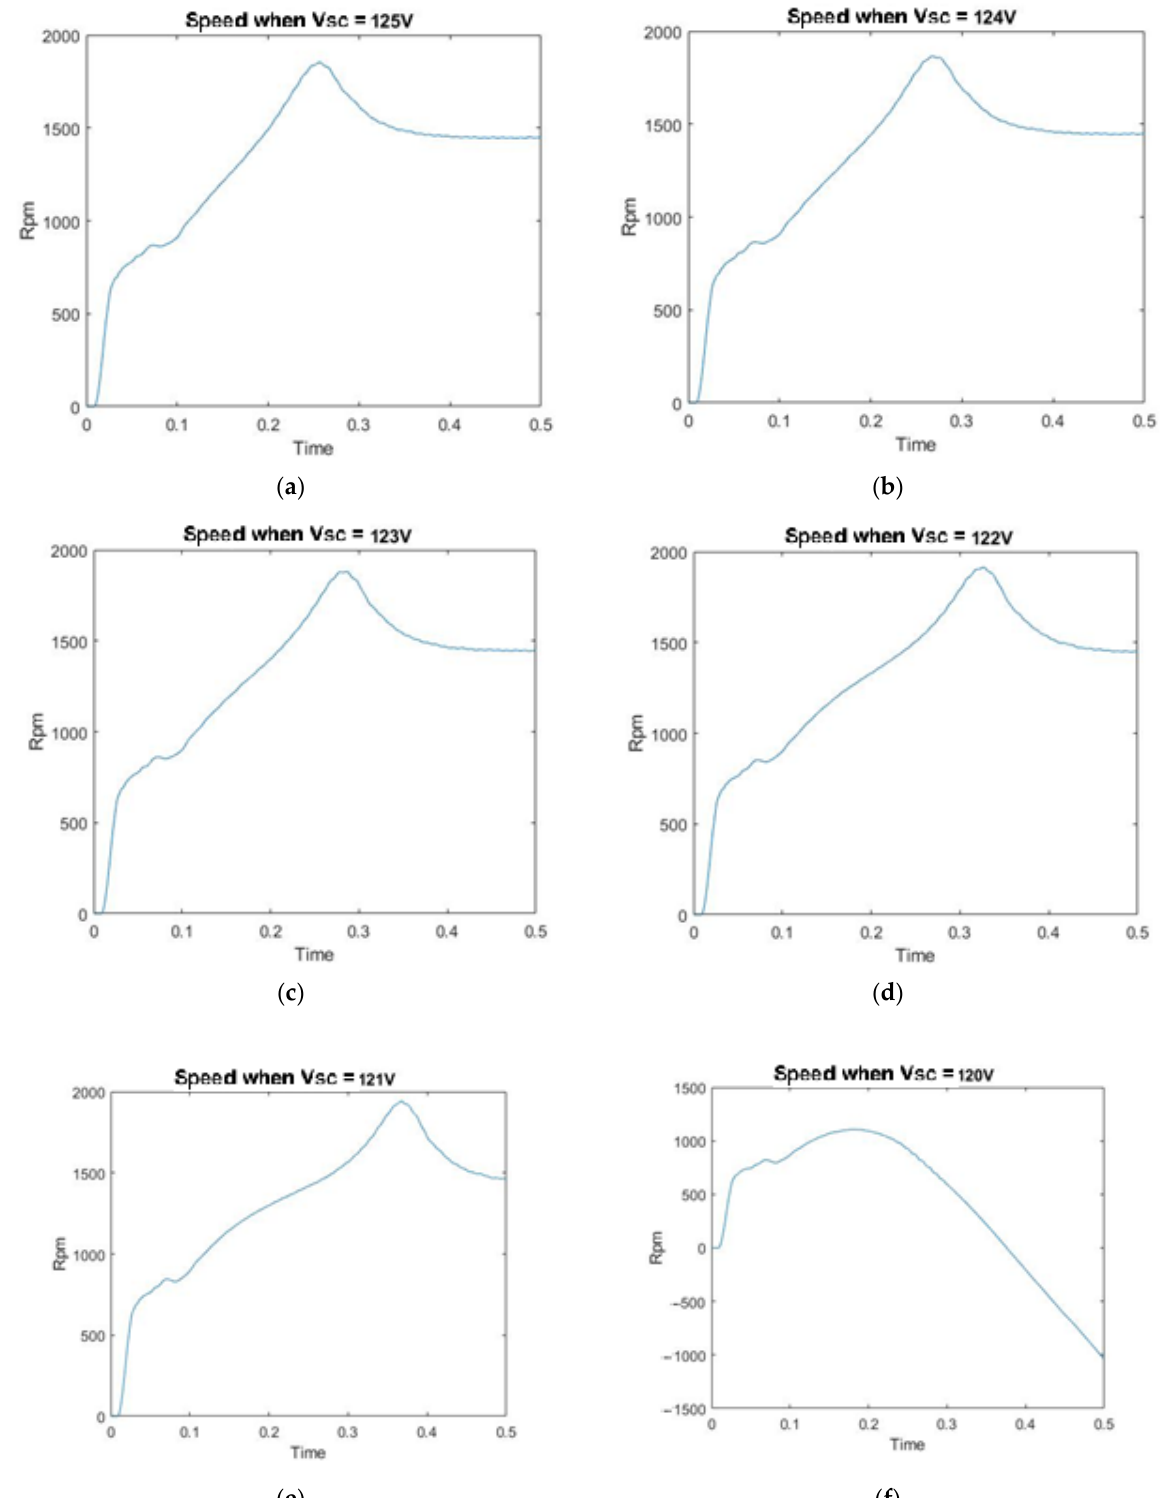
Figure 16. Speed of the electric drive at different voltage of the supercapacitor: ( a ) 125 V; ( b ) 124 V; ( c ) 123 V; ( d ) 122 V; ( e ) 121 V and ( f ) 120 V.